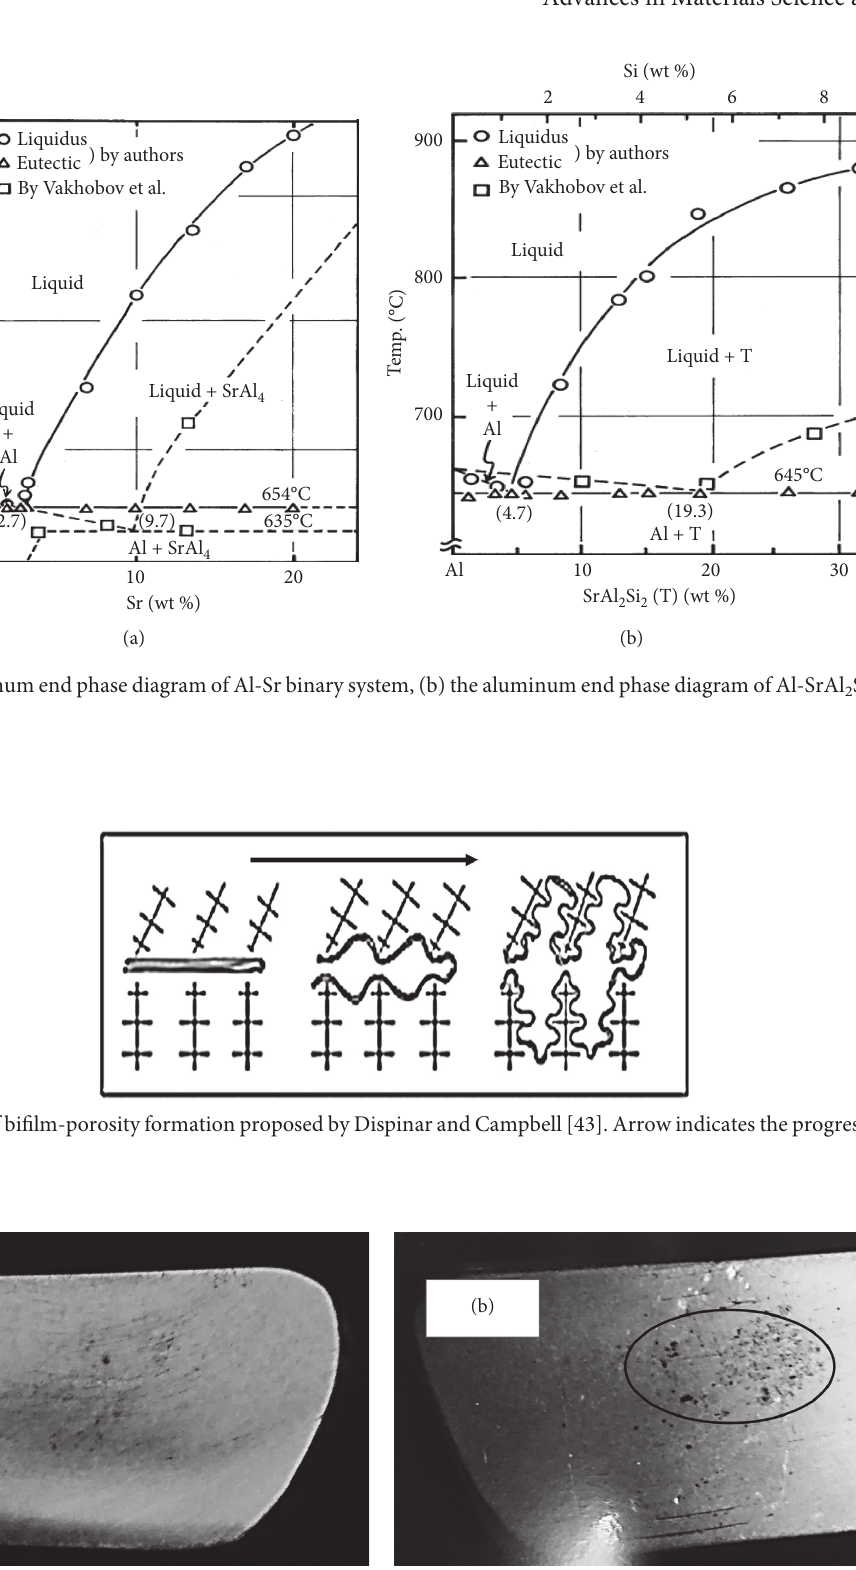
Figure 20: RPTsamples obtained from alloy A356 melt after (a) degassing and (b) addition of 200ppm Sr. Note: the porosity in the circled area in (b).